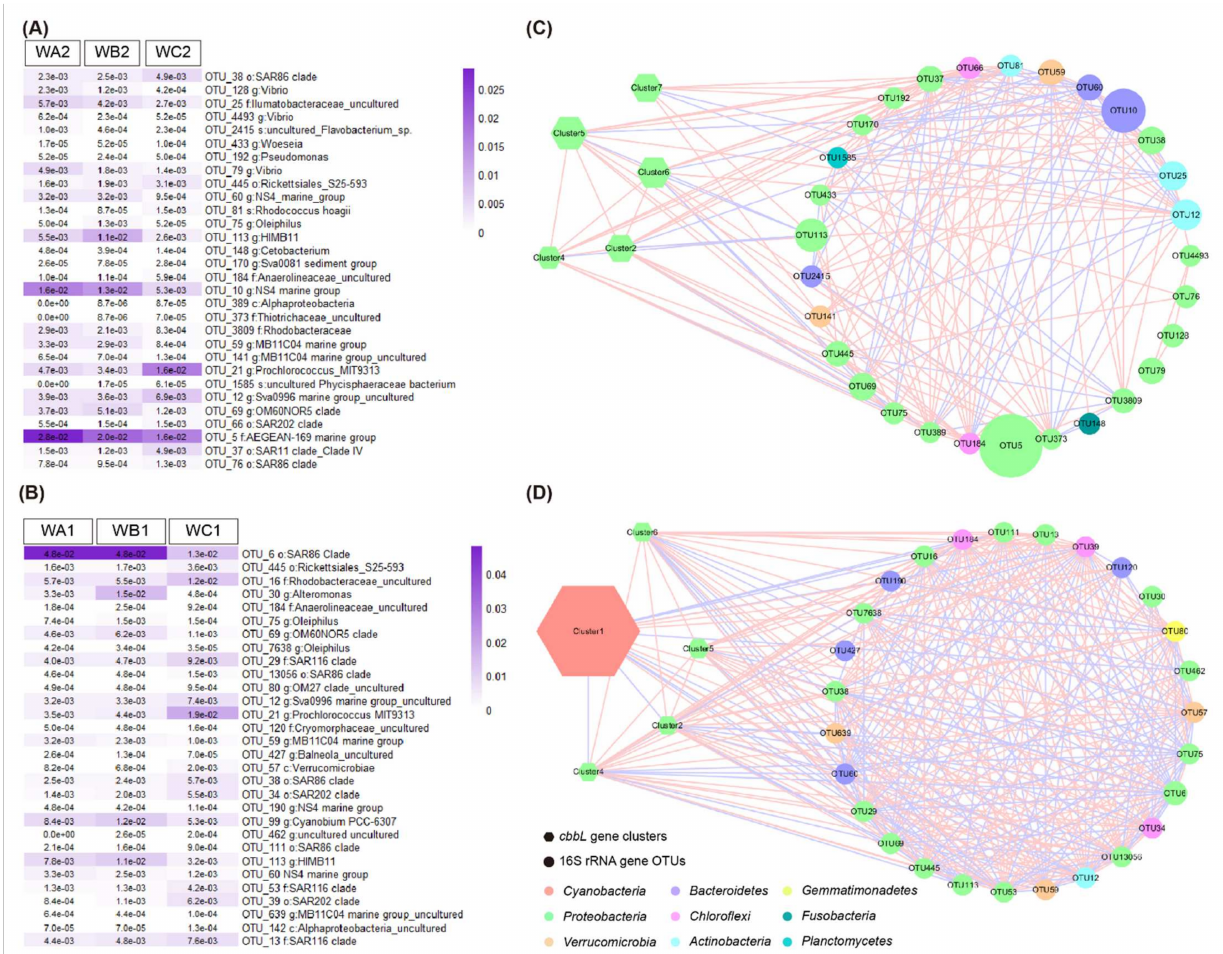
Figure 5. Correlation of key 16S rRNA gene OTUs and cbbL gene clusters. ( A , B ) Abundance of top 30 key 16S rRNA gene OTUs in surface ( A ) and bottom water ( B ) selected by Random Forest machine learning. ( C , D ) The co-occurrence network of key 16S rRNA gene OTUs and cbbL gene clusters in surface water ( C ) and bottom water ( D ). Node size indicated the abundance of the